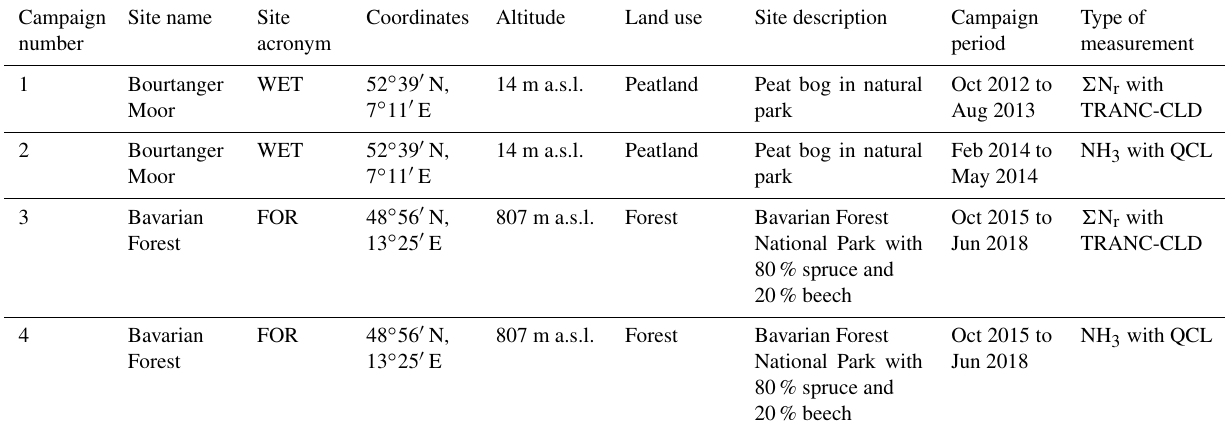
Table 1. Overview of field campaigns with (cid:54) N r referring to the sum of all reactive nitrogen compounds, with TRANC being the Total Reactive Atmospheric Nitrogen Converter, QCL being a quantum cascade laser spectrometer, and CLD being a chemiluminescence detector.